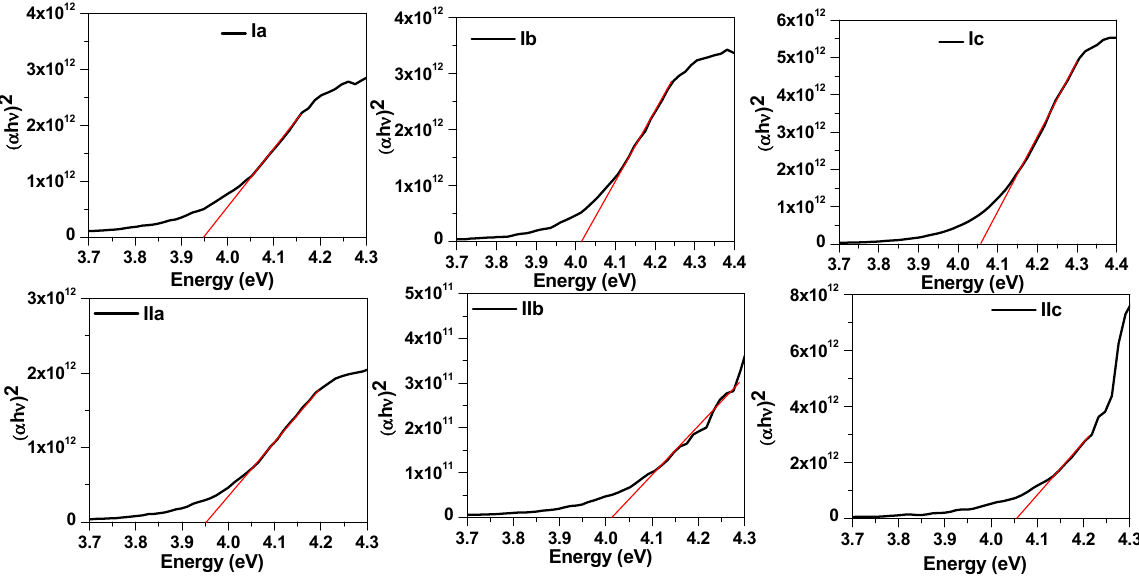
Figure 7. Tauc plots of synthesized liquid crystalline materials.